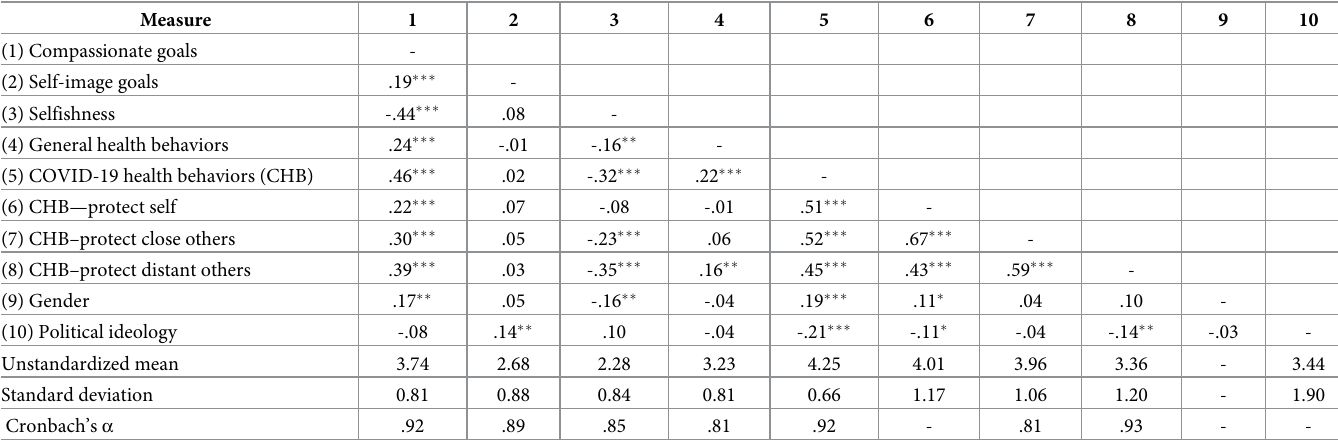
Table 1. Descriptive statistics and zero-order correlations in Study